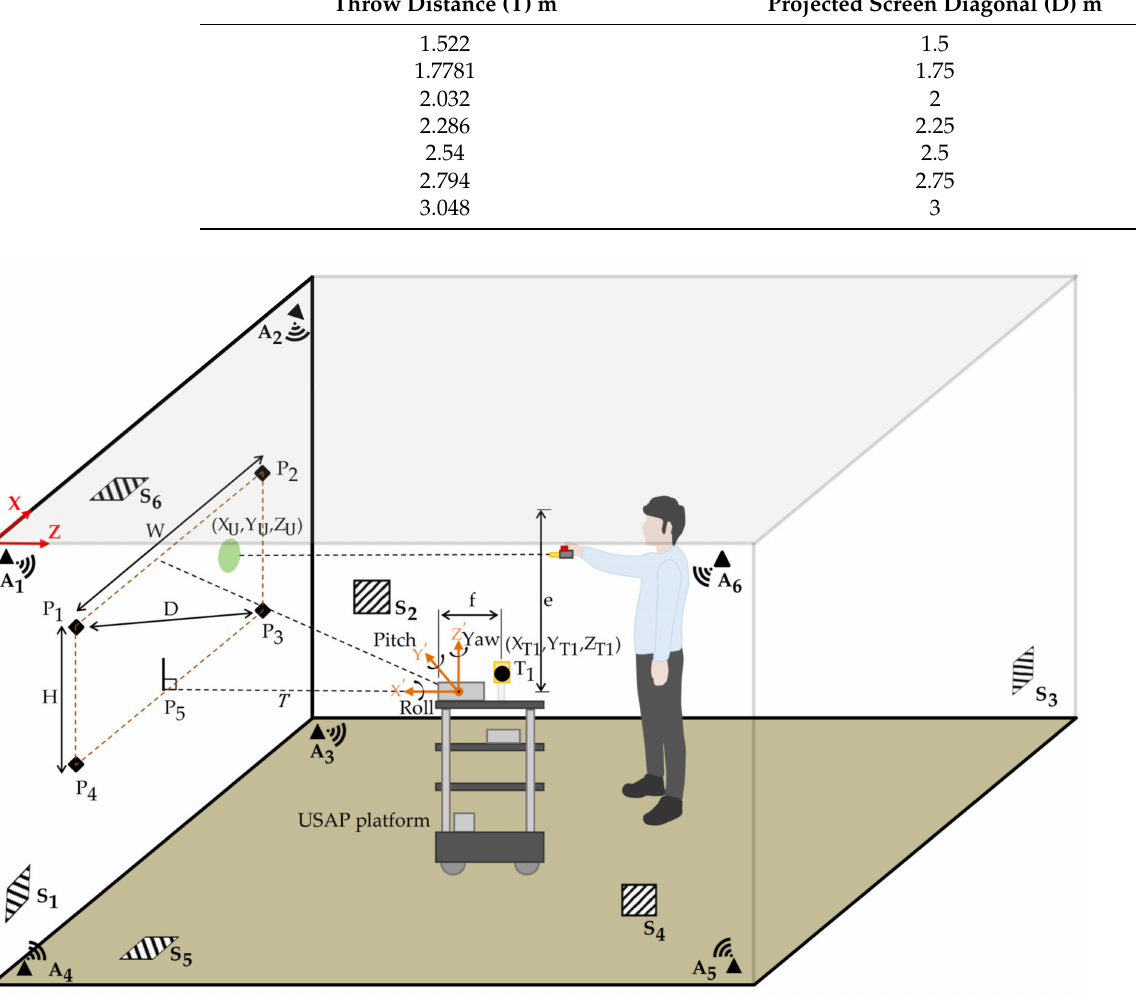
Figure 4. Proposed projection scheme along with UWB-based calibration